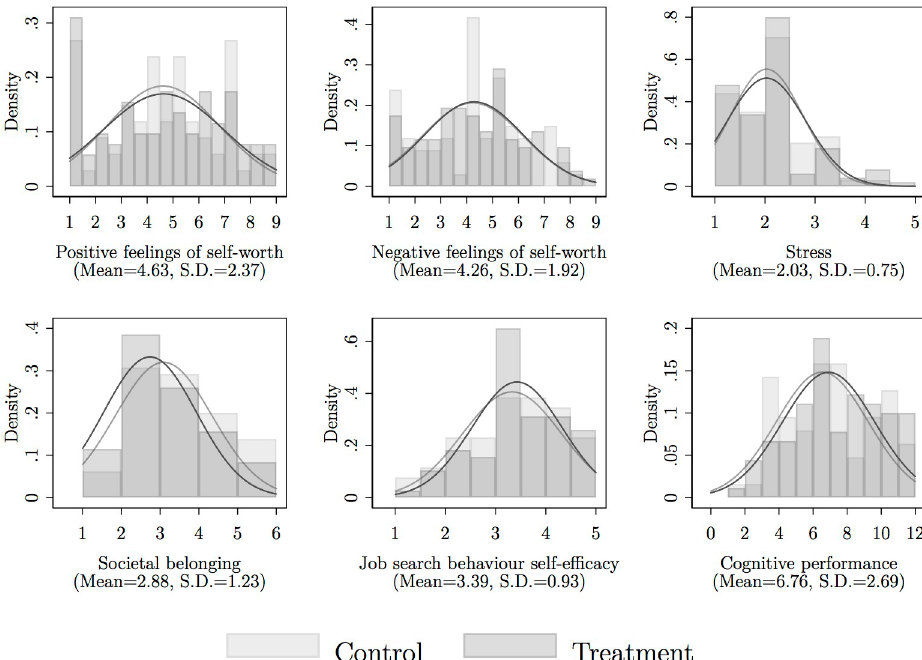
Fig 2. Histograms and kernel density of outcome variables, by treatment and control group. Source : Author’s own calculations.